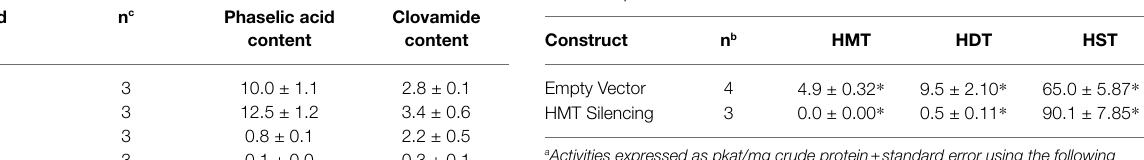
TABLE 4 | Hydroxycinnamoyl-CoA transferase activities a in extracts of unexpanded leaves of control and HMT-silenced (“Severe” phenotype, Table 3 ) red clover